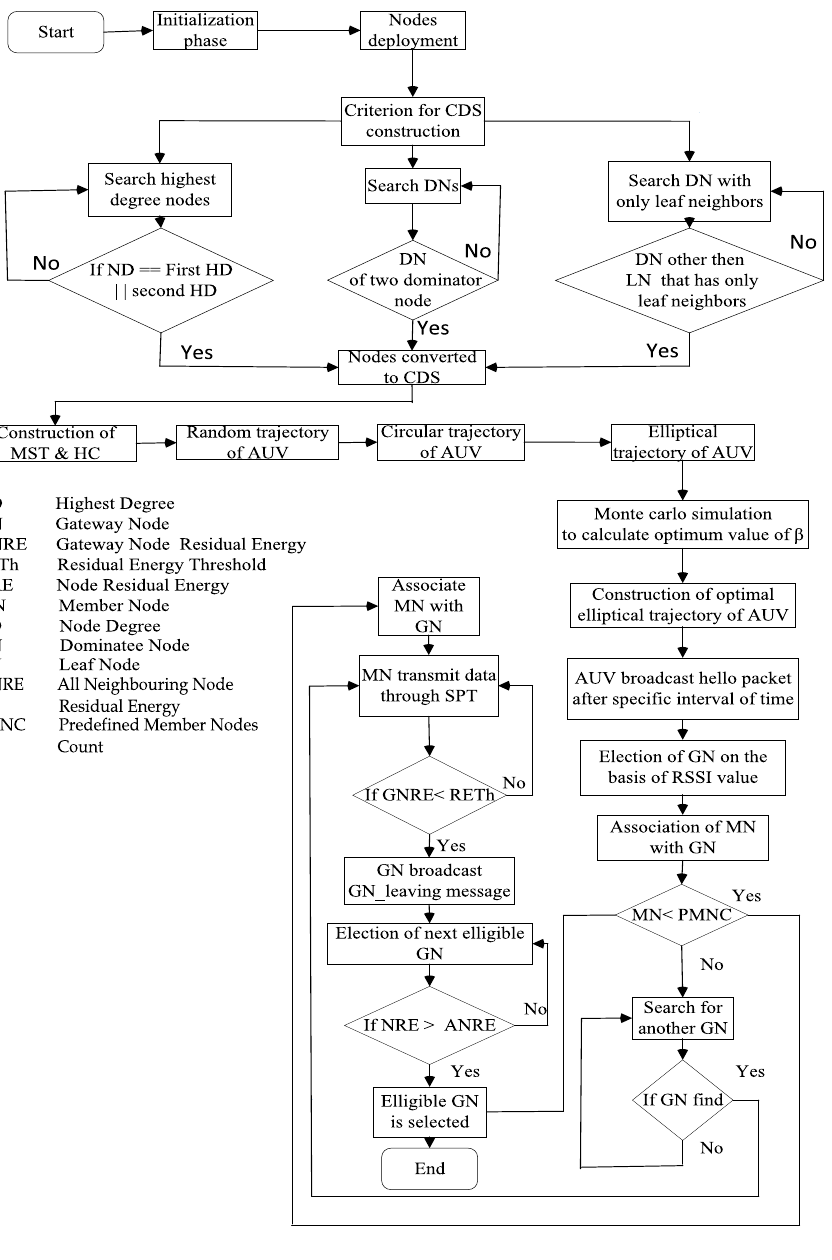
Figure 8. AEDG: protocol